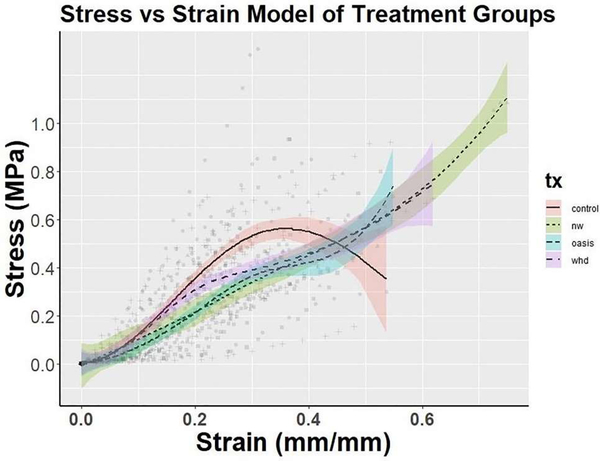
Stress vs. Strain analysis of excised murine skin for each treatment. Lines represent spline regression models with 95% confidence intervals. Data was divided into 3 intervals x<0.2, 0.2 ≤ x ≤ 0.3, and x>0.3 applying a cubic prediction model to each section. Although not statistically significant, due to the amount of variation introduced as strain increases, WHD withstood more than 0.4 MPa of stress before yielding compared to control. NW group: Non-wounded skin.